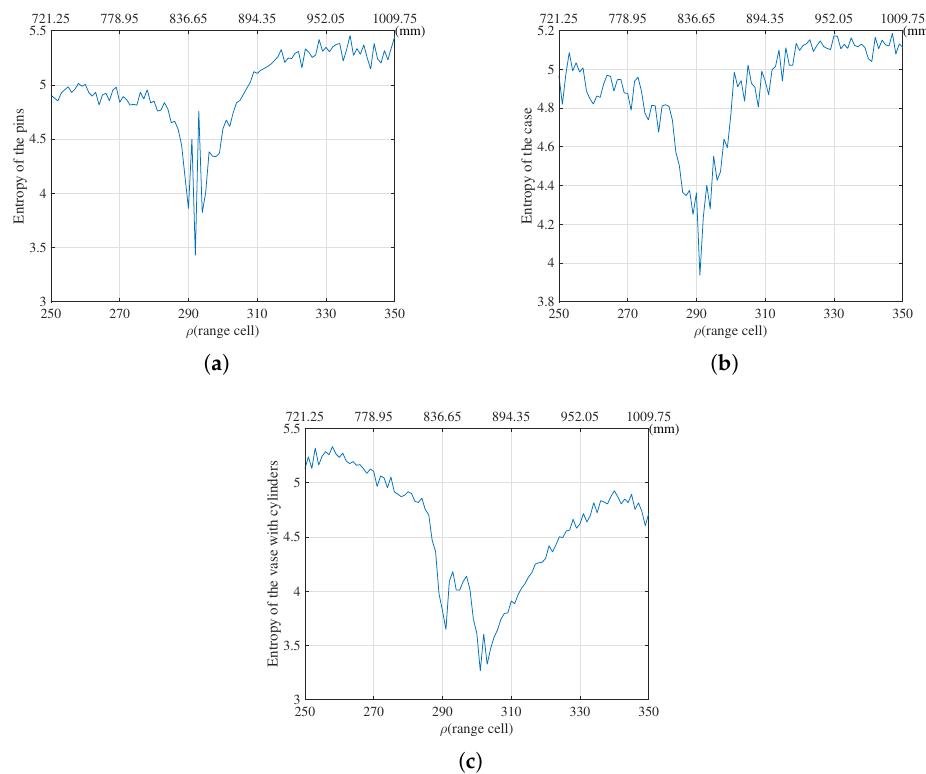
Figure 6. Entropy of the three different sets of targets with respect to ρ . ( a ) The entropy with respect to ρ from the radar image of the pins. The minimum peak at 292th range cell is used; ( b ) The entropy with respect to ρ from the radar image of the metal pen and pencil case. The minimum peak at 291th range cell was used; ( c ) The entropy with respect to ρ from the radar image of cylindrical pencil vase with cylinders. The minimum peak was definite at 301th range cell.